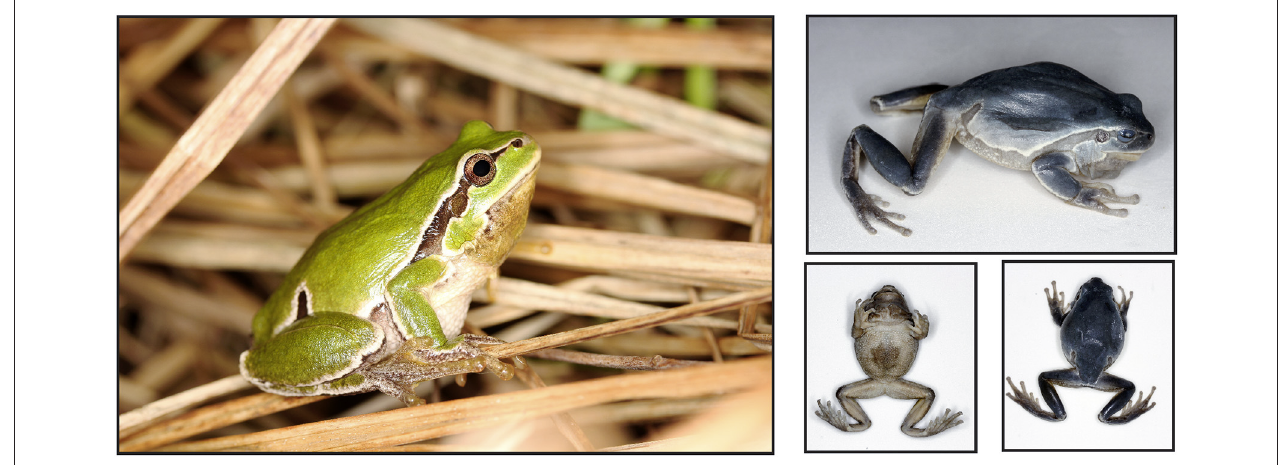
FIGURE 8 | The holotype of Hyla perrini sp. nov. in life and deposited at the Cantonal Museum of Zoology of Lausanne, under voucher